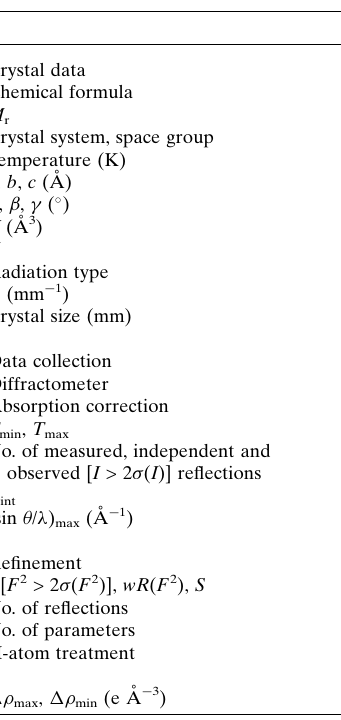
Table 3 Experimental details.